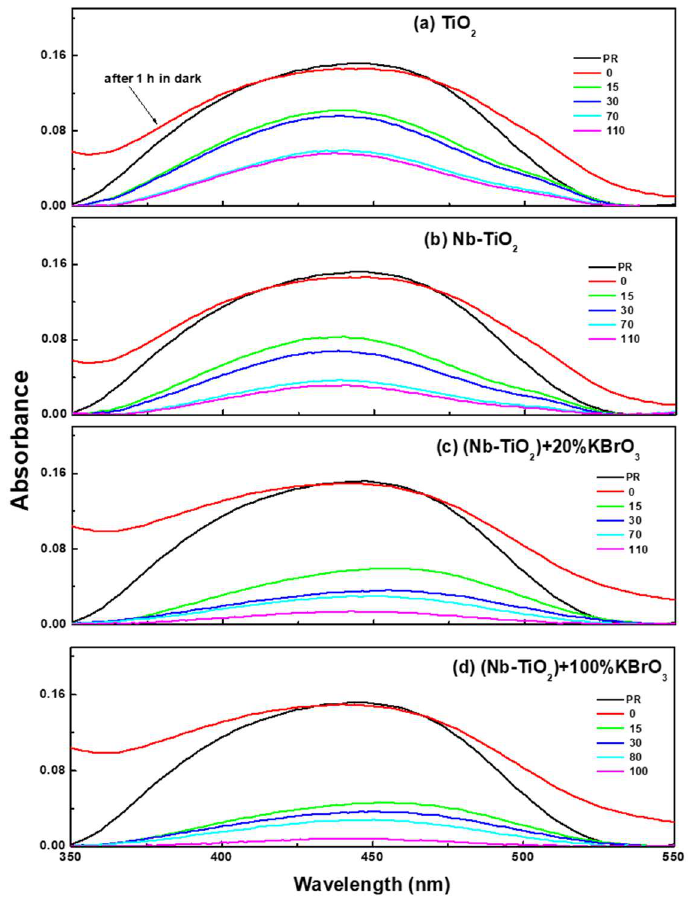
Figure 1. Absorbance spectra by the exposure time for pure TiO 2 , Nb-TiO 2 , Nb-TiO 2 /20%KBrO 3, and Nb-TiO 2 /100%KBrO 3 .